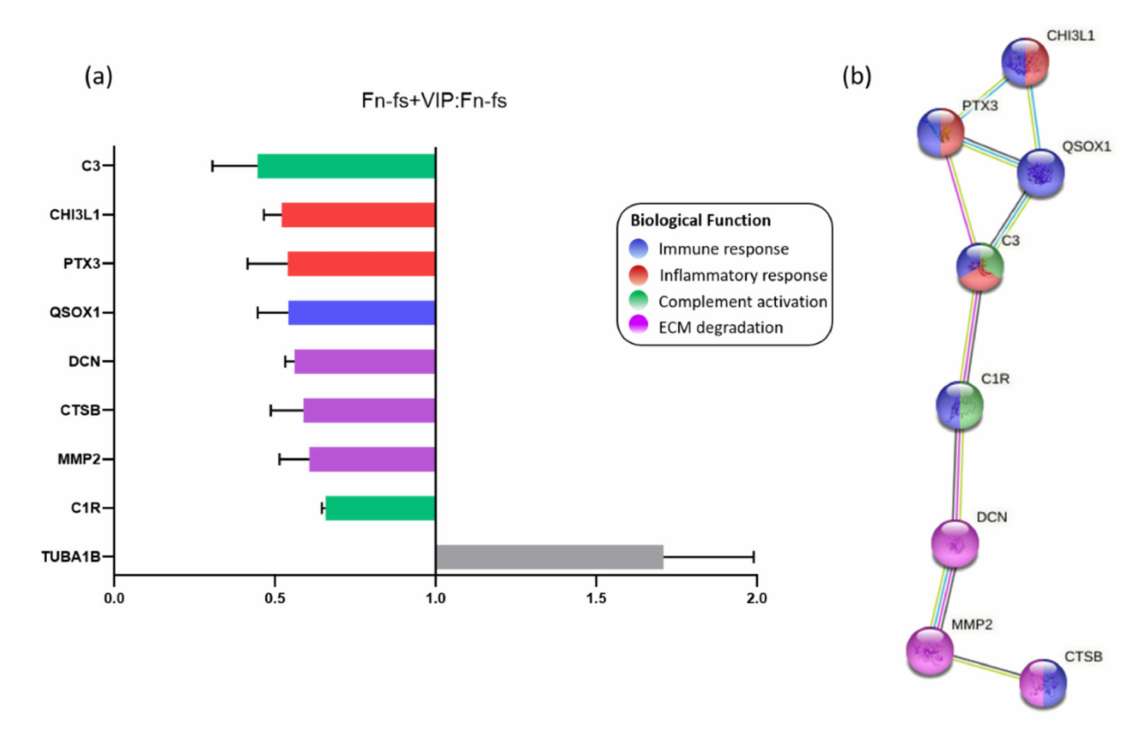
Figure 2. VIP-modulated proteins in the SF-AC co-cultures secretome. ( a ) Average SILAC ratios ( n = 4) that represent the relative protein abundance in Fn-fs+VIP versus Fn-fs treated SF-AC co-cultures at the same time point (48 h). Ratios are presented as the media of the replicates forward and reverse for each patient. ( b ) Functional protein association networks and biological processes where the proteins downregulated by VIP are involved, according to the STRING database. Table 2. VIP-modulated proteins in the in the Fn-fs-stimulated secretome of OA SF-AC co-cultures identified by